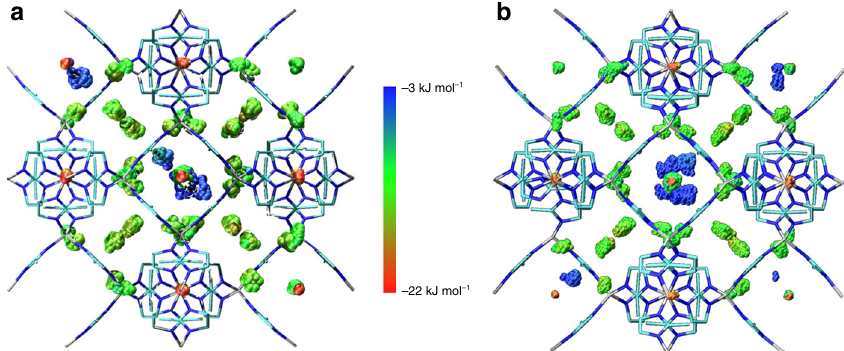
Fig. 6 GCMC adsorption sites of N 2 and O 2 . a Heat map of N 2 in ZIF-8-HP. b Heat map of O 2 in ZIF-8-HP. Points are centre of masses of diatomic molecules and the colour represents the framework – fl uid interaction energy. Red corresponds to low energy (strong interaction) and blue to high energy (weak